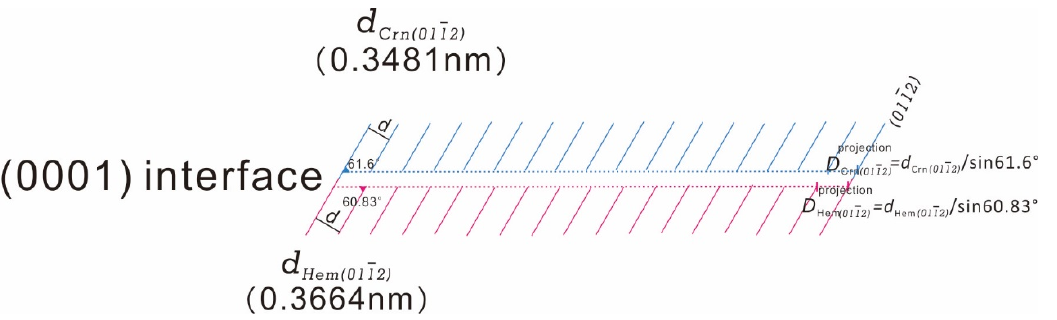
() ] and 16-  () /sin60.83°